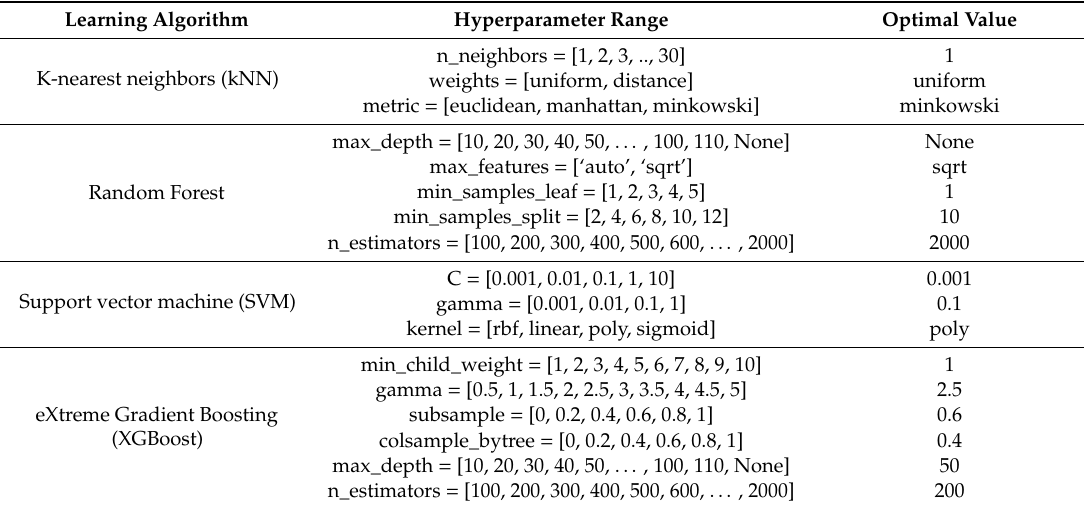
Table 3. Hyperparameter search range and optimal values for each learning algorithm.